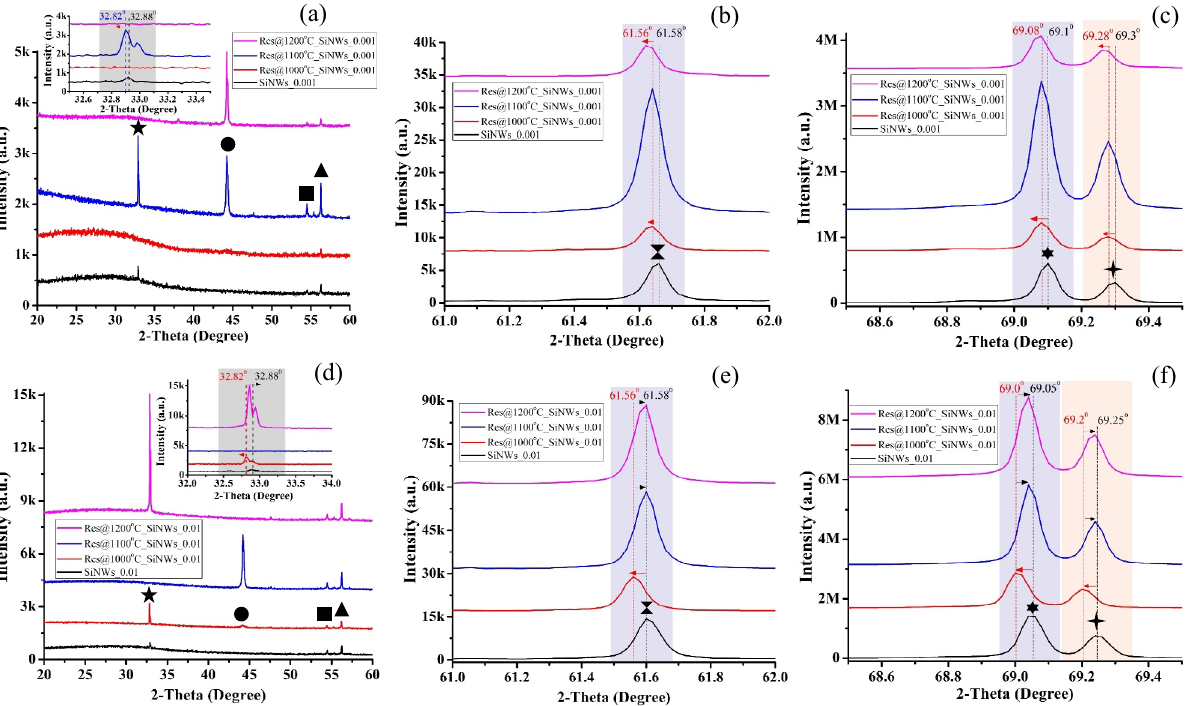
Figure 3. XRD pattern of pristine and sintered SiNWs_0.001 ( a , b , c ), SiNWs_0.01 ( d , e , f ). The symbol represents Filled black star (32.9°) Si (111), filled black circle (44.2°) Ag (200), filled black square (54.5°) Ag 2 O (220), filled black upward triangle (56.3°) Ag (220), black hourglass(61.6°) Si (400), (69.1°) Si (400), and (69.3°)